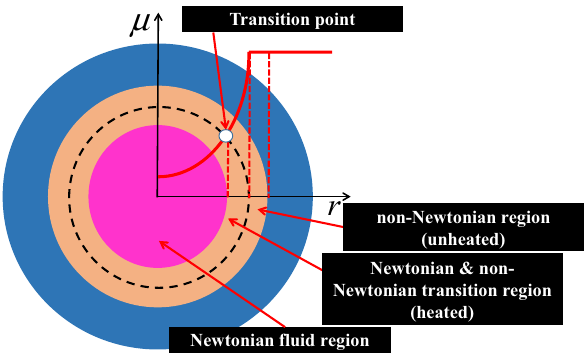
Fig. 3 The distribution of Newtonian region, transition region, and non-Newtonian fluid in the reservoir